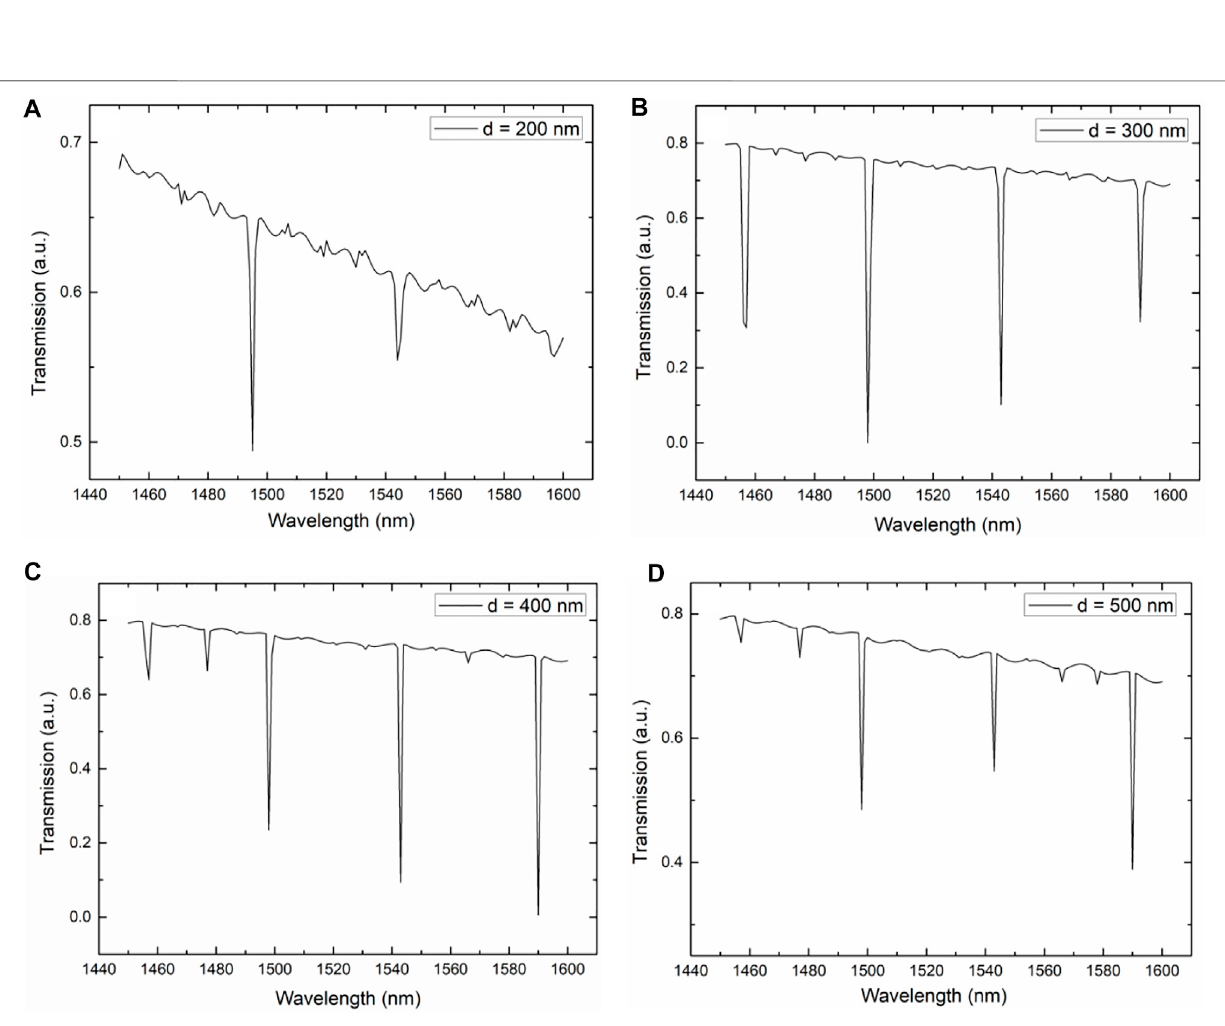
Frontiers in Physics |